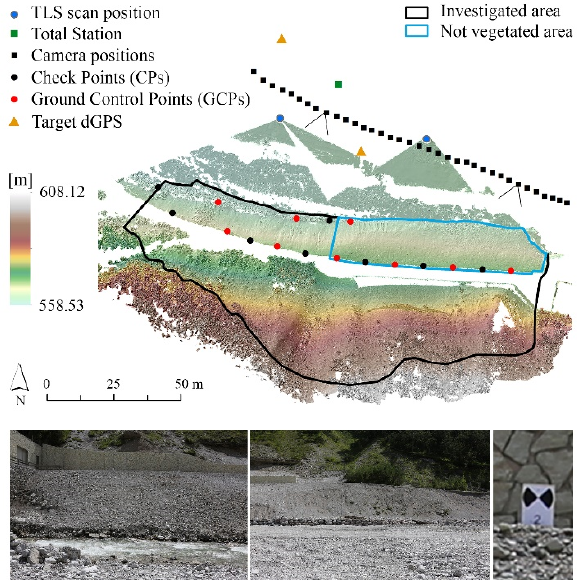
Figure 1. Top: configuration of topographic surveys and TLS survey, and camera network geometry. TLS elevation model with the GCPs (red points) and CPs (black points). The black line represents the investigated area and the blue line the perimeter of area not covered by vegetation. Bottom: images of the test area and a black and white flat target for the photogrammetric